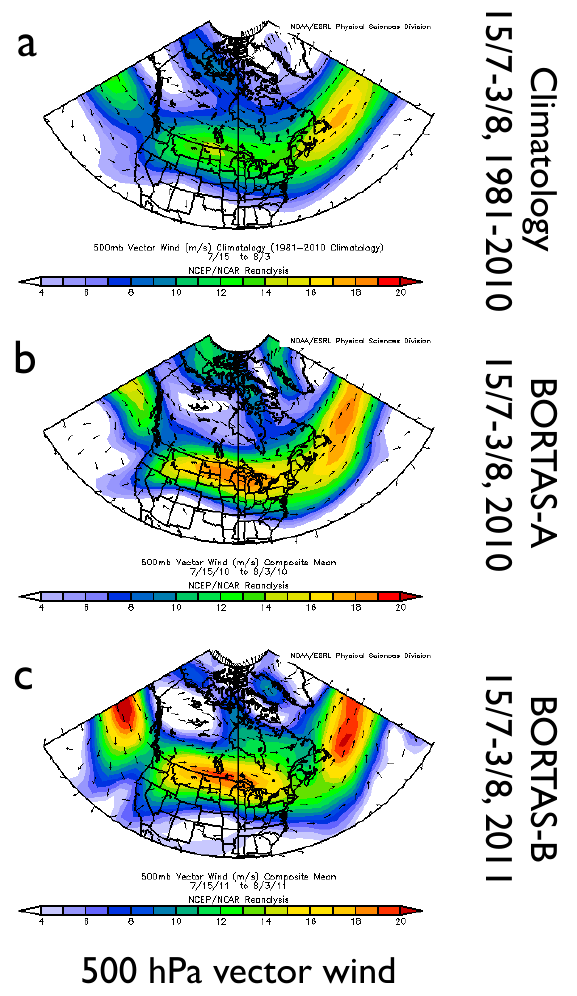
Fig. 3. Climatological mean 500hPa wind vector (ms − 1 ) over North America for 15 July–3 August for the period 1981-2010 (a) , and the corresponding departure of those means for 15 July–3 Au- gust 2010 (b) and for 15 July–3 August 2011 (c) . Image provided by the NOAA/ESRL Physical Science Division, Boulder, Colorado (